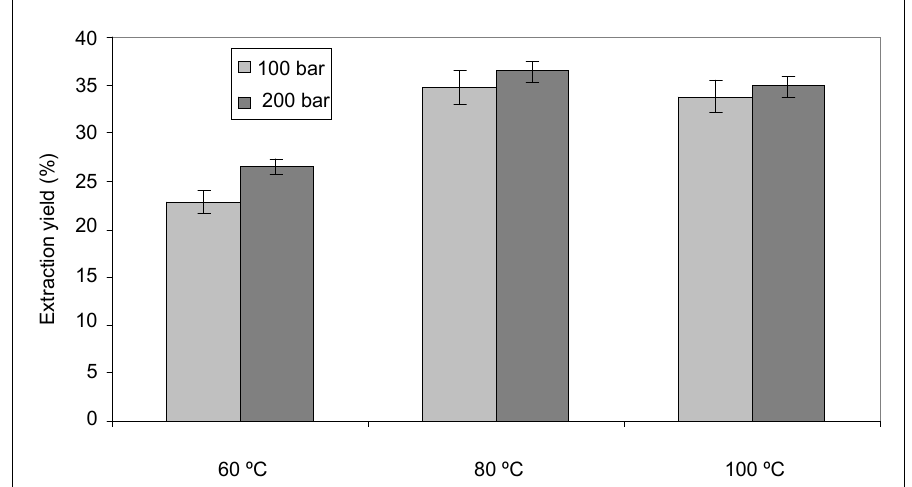
Figure 4. Extraction yield of extracts obtained by PLE at different pressures and